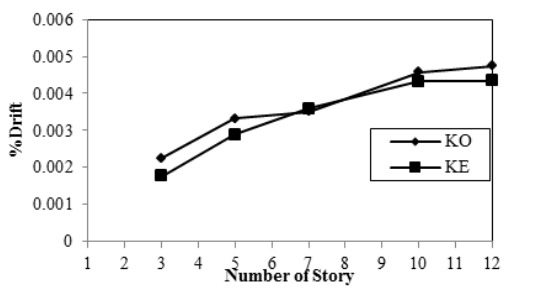
Fig. 10. Comparison of average of maximum drift of KO with KE frames under incremental nonlinear dynamic analysis with scaled ground acceleration (PGA) to 0.35g.